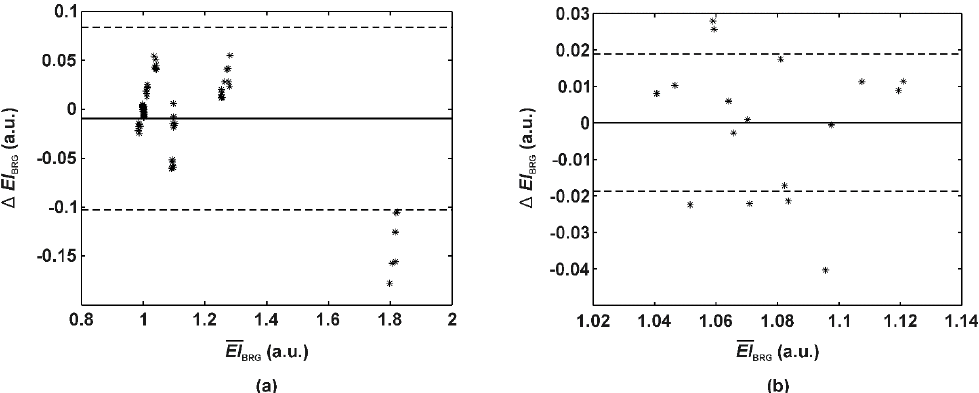
Figure 8. Bland-Altman plots on erythema index agreement between both smartphones. EI BRG is based on ( a ) the full-range CCT patches (No: 1–3, 5, 8, 9, and 19–24) or ( b ) canine skin. Mean difference and 95% limits of agreement (±1.96 STD) are marked as full and dotted lines, respectively.